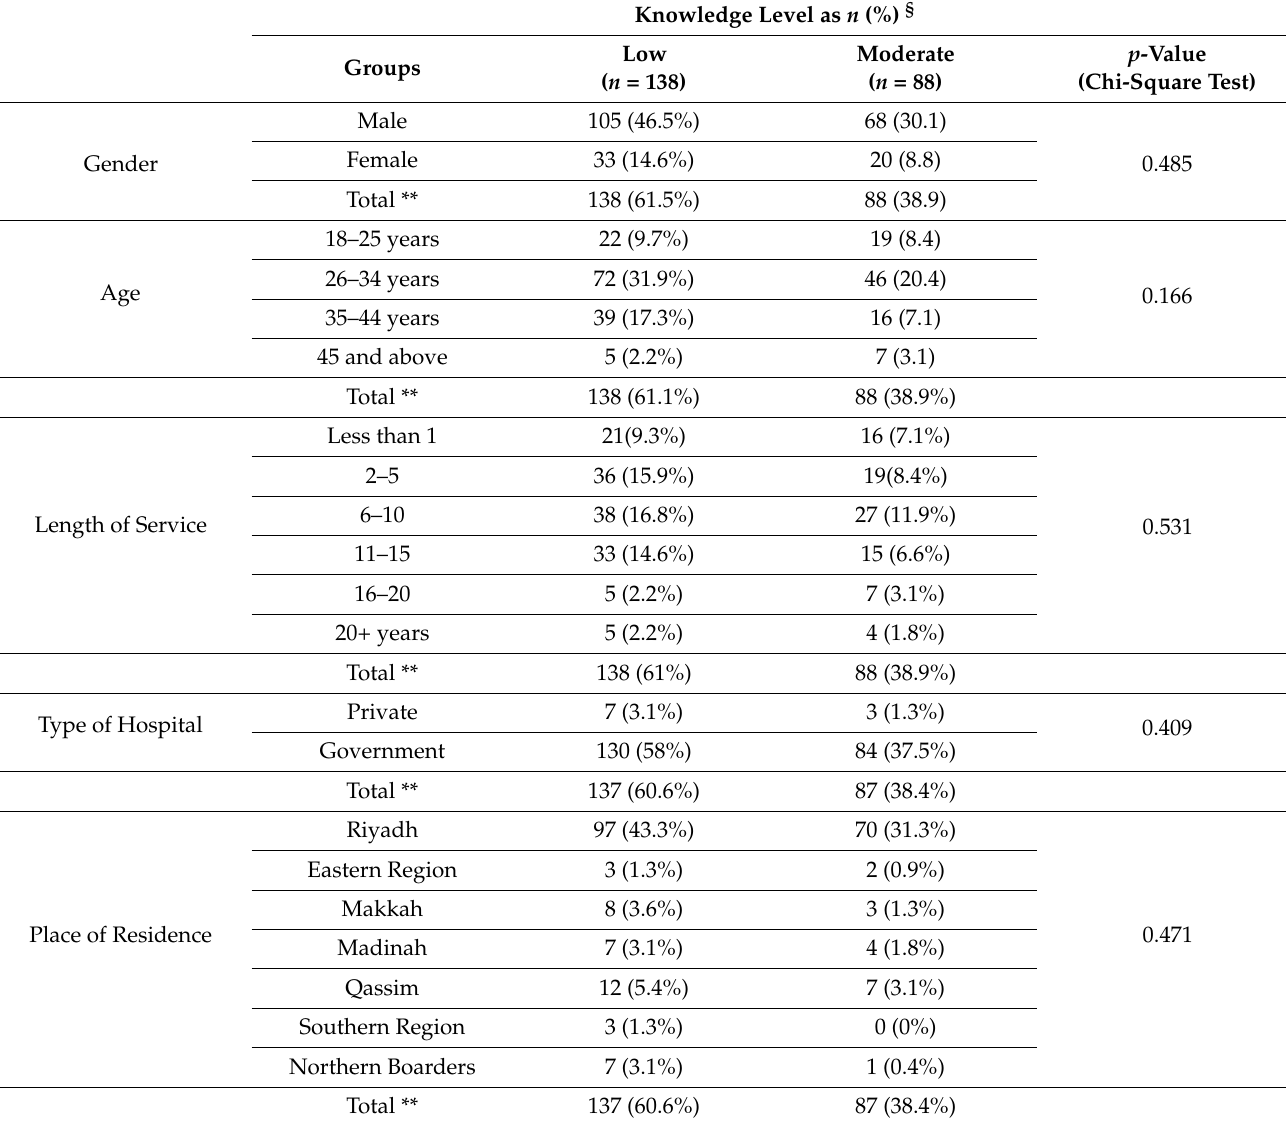
Table 5. Level of knowledge and competency concerning a